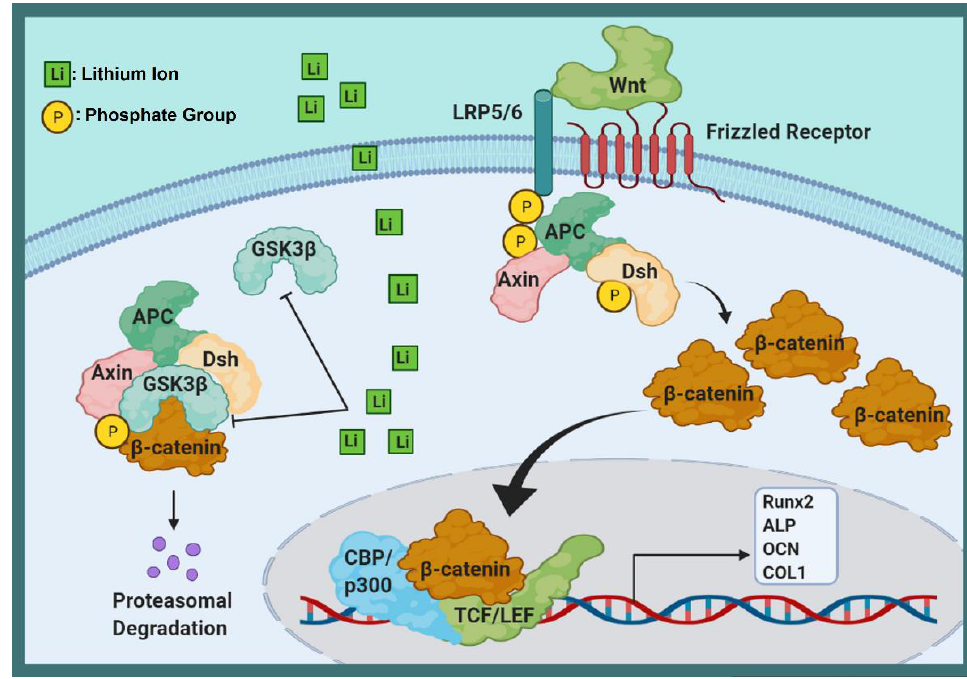
Figure 11. Schematic representation of Li ions interaction with cells.